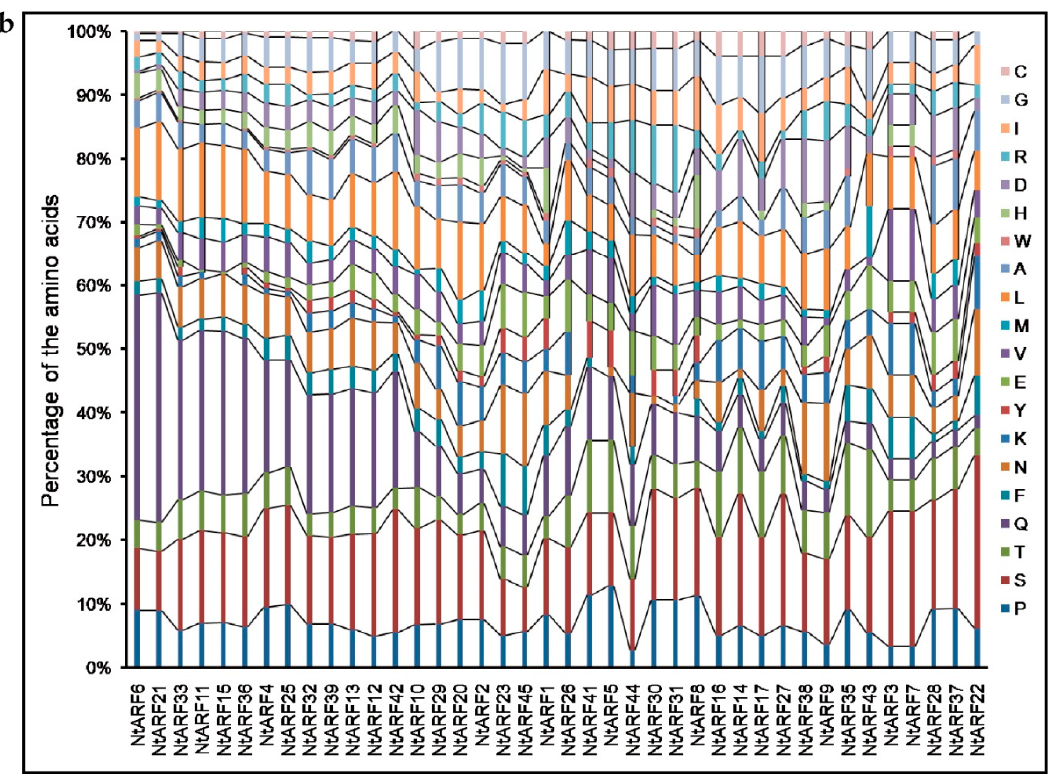
Figure 10. Multiple alignments ( a ) and analysis of amino acid content ( b ) of middle domain in NtARF proteins.